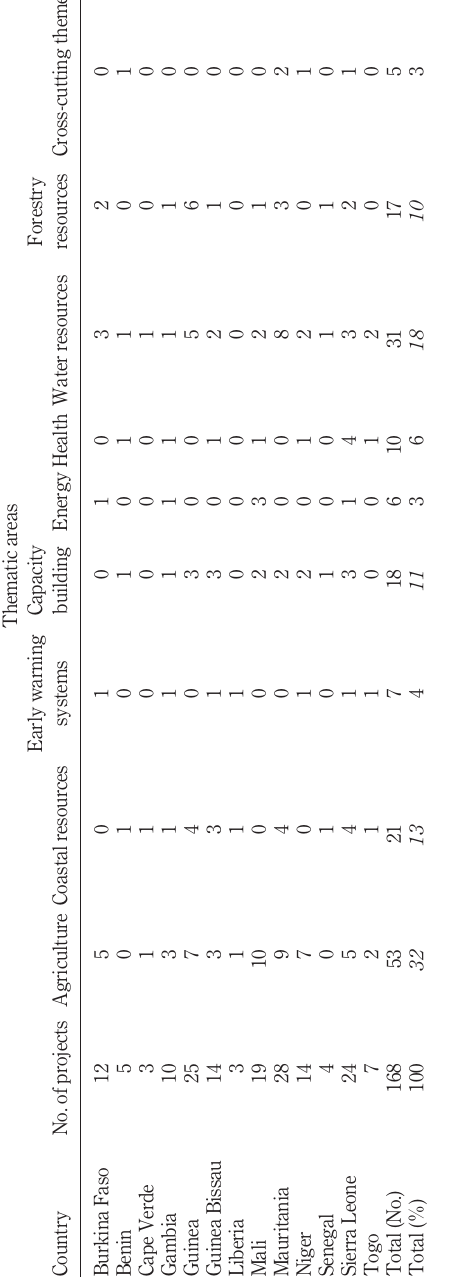
Projects distribution per country and thematic areas